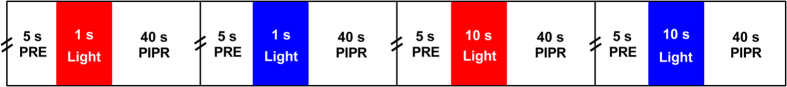
Stimulus protocol for pupillometry.Red stimuli (red rectangles) and blue stimuli (blue rectangles) were alternated. The double slash before each 5 s pre-stimulus duration indicates a 10 s interval. Measurements were repeated twice; a two minutes break was given between the repeats of this sequence. PRE = pre-stimulus duration; PIPR = post-illumination pupil response.